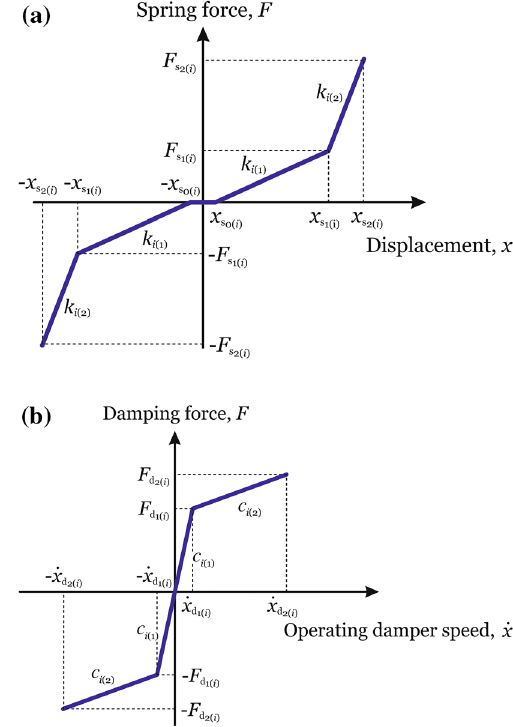
Fig. 2 Characteristics of inter-vehicle connection components: a shows a relationship between spring force and displacement of the semi-permanent tight-lock coupler, whereas b demonstrates a damping force characteristic of the longitudinal inter-vehicle damper (in both cases, the sub-index i stands for the sequence number of the advanced inter-vehicle